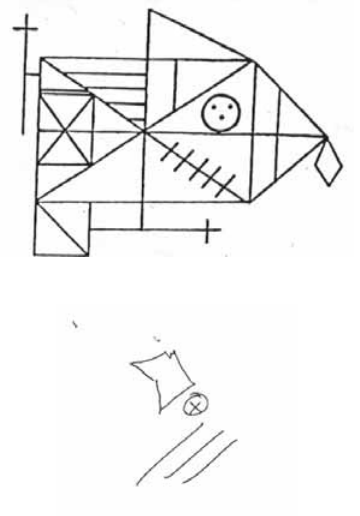
Fig. 3. Impaired Copying Ability. Fifty-eight year-old man with impaired visual-spatial skills due to PCA was unable to directly copy the Rey-Osterreith complex